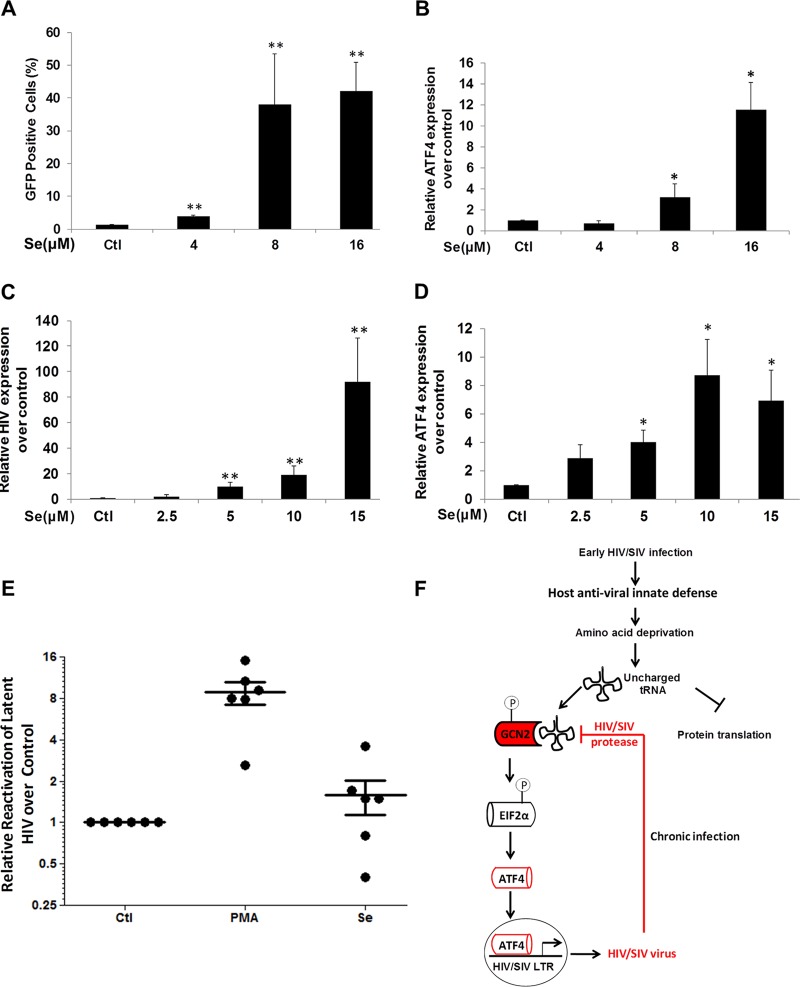
Induction of ATF4 expression by selenium reactivates latent HIV. (A) J-Lat cells were treated with 4 to 16 μM selenium for 24 h, and GFP expression was assessed using flow cytometry to determine latent HIV LTR reactivation. **, P < 0.01. (B) J-Lat cells were treated with 4 to 16 μM selenium for 24 h, and ATF4 gene expression was determined by RT-qPCR. *, P < 0.05. (C) U1 cells were treated with 2.5 to 15 μM selenium for 24 h, and viral expression was assessed by RT-qPCR to determine latent HIV reactivation. **, P < 0.01. (D) The U1 cells were treated with 2.5 to 15 μM selenium for 24 h, and ATF4 gene expression was determined by RT-qPCR. *, P < 0.05. (E) Isolated primary CD4+ T cells from HIV-infected individuals on suppressive ART were treated with DMSO, 200 ng/ml PMA plus 2 µM ionomycin, or 16 μM selenium for 6 h. Induction of HIV transcription was measured by RT-qPCR for the 5′ LTR region of the virus. (F) The proposed model for the GCN2-eIF2α signaling in early HIV replication. HIV/SIV infection induces antiviral host innate defense to restrict viral production by reducing amino acid deficiency and shutting down protein synthesis. This triggers GCN2-eIF2α signaling and induces ATF4 expression. The virus hijacks this mechanism to recruit ATF4 to the viral LTR and enhance viral replication. During the advanced HIV infection, GCN2 is degraded by HIV protease, the level of ATF4 decreases, and its impact is diminished. Thus, ATF4 may be critical in the initial stages of HIV replication. Data from panels A to D were from three independent experiments.